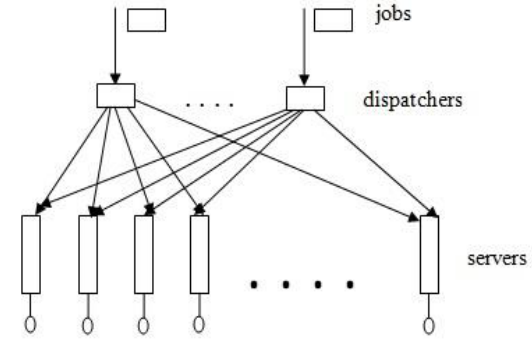
Figure 1. Distributed dispatchers for a cluster of parallel